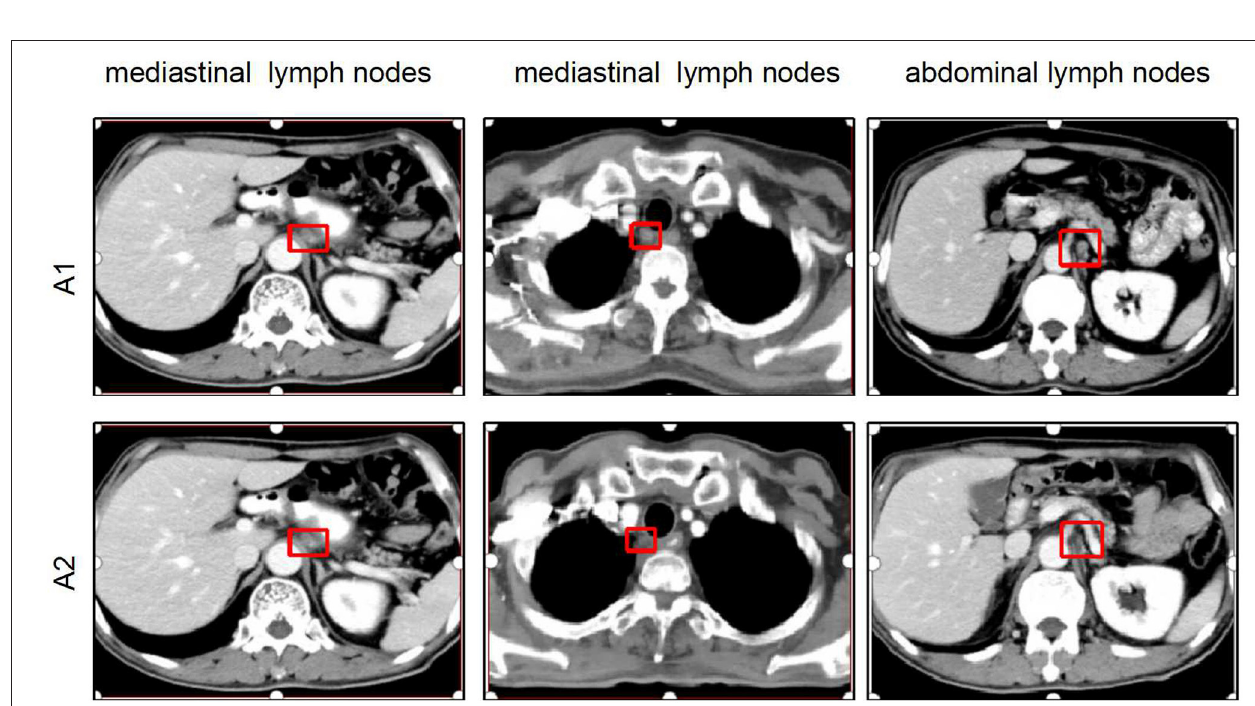
FIGURE 14 | Comparison of chest CT scan between before and after treatment for the first patient. (A1) Chest CT scan showing enlarged lymph nodes in the retroperitoneum and mediastinum in postoperative re-examination. (A2) Chest CT showing that the enlarged lymph nodes in the retroperitoneum and mediastinum shrank or became loosened after 6 weeks of anlotinib combined chemoradiotherapy. CT, computed tomography; PD, progressive disease; PR, partial progressive